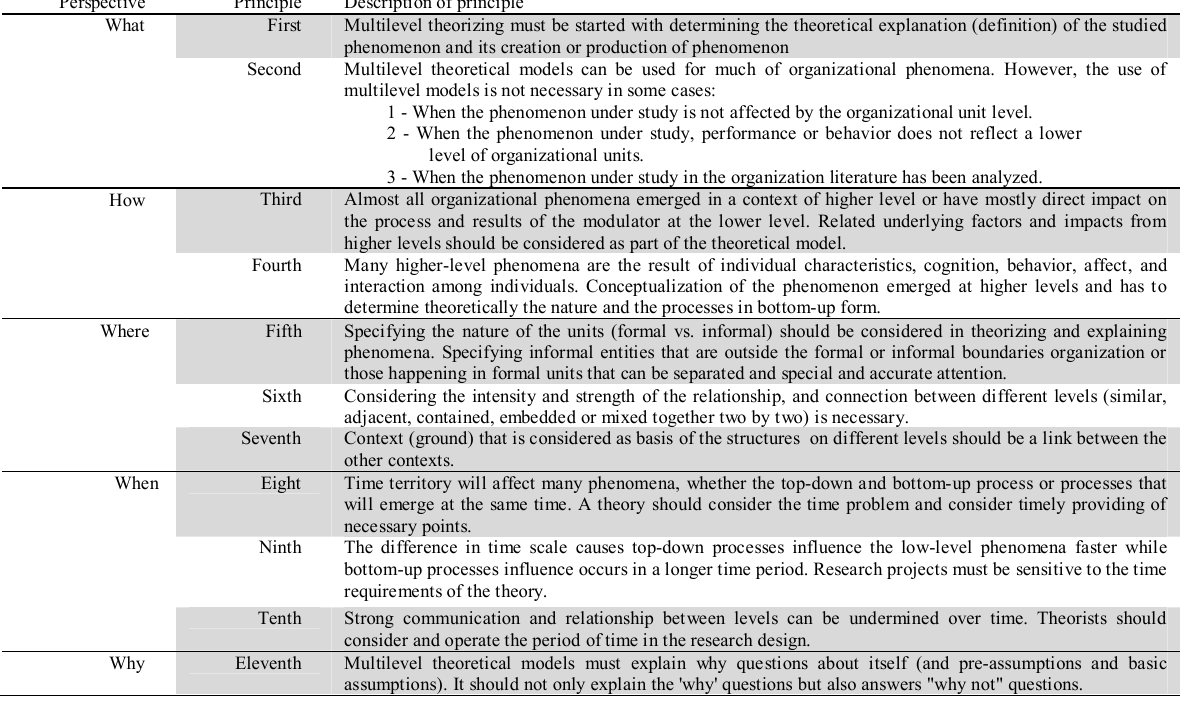
Basic principles of multilevel